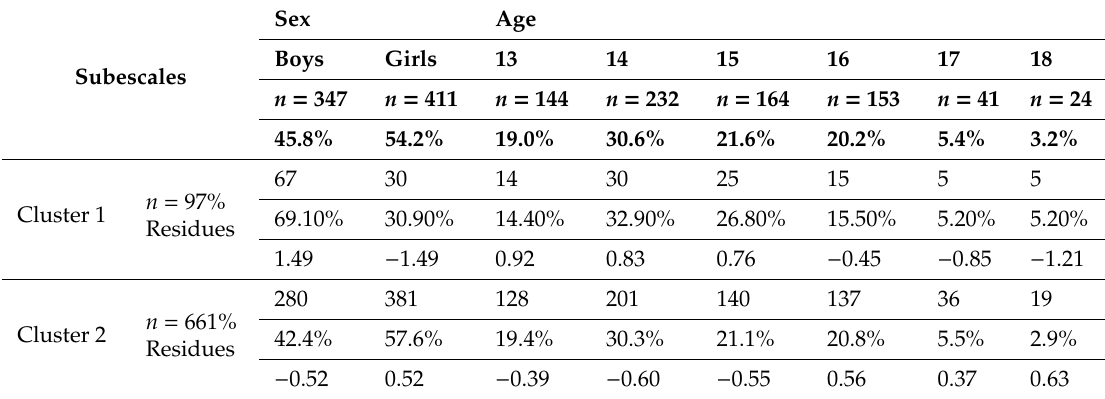
Table 4. Clusters’ characteristics according to sex and